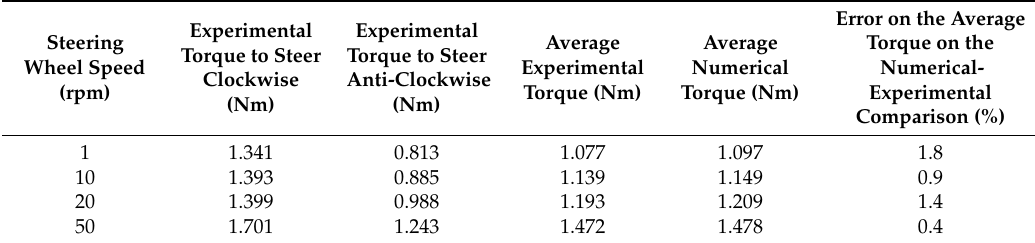
Table 2. Comparison between the measured and numerical torque at the steering wheel.